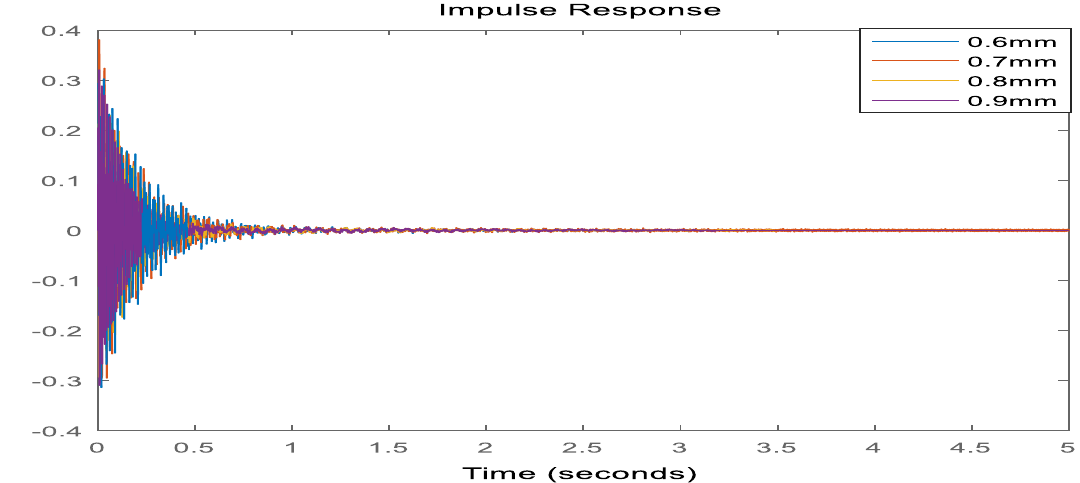
Figure 14. System response of viscoelastic material layer with different thickness (applied voltage).